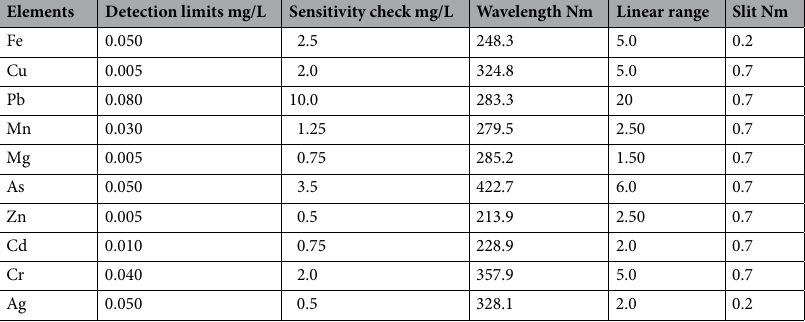
Table 1. Background information of the buck scientific atomic absorption